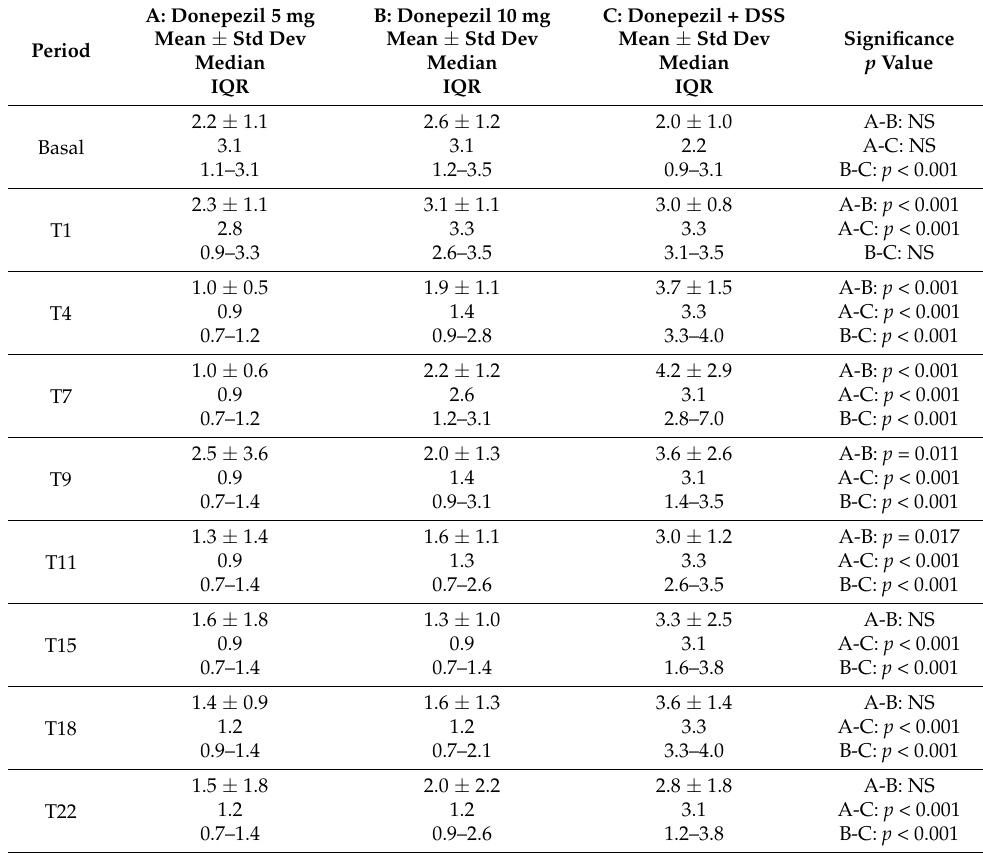
Figure 8. Electrogastrography. Dominant frequency after a single intragastric dose of donepezil (5 mg; group A).